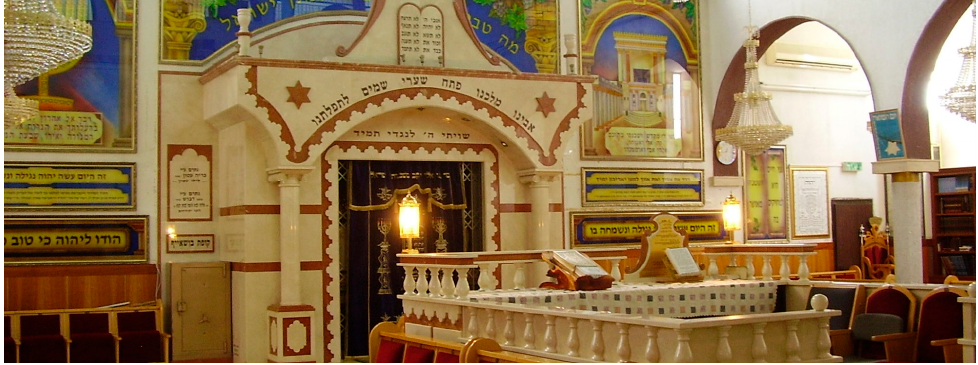
Figure 9. Interior, Bushaeff synagogue, Zeitan (http://www.bushaeff.co.il/, 2020).